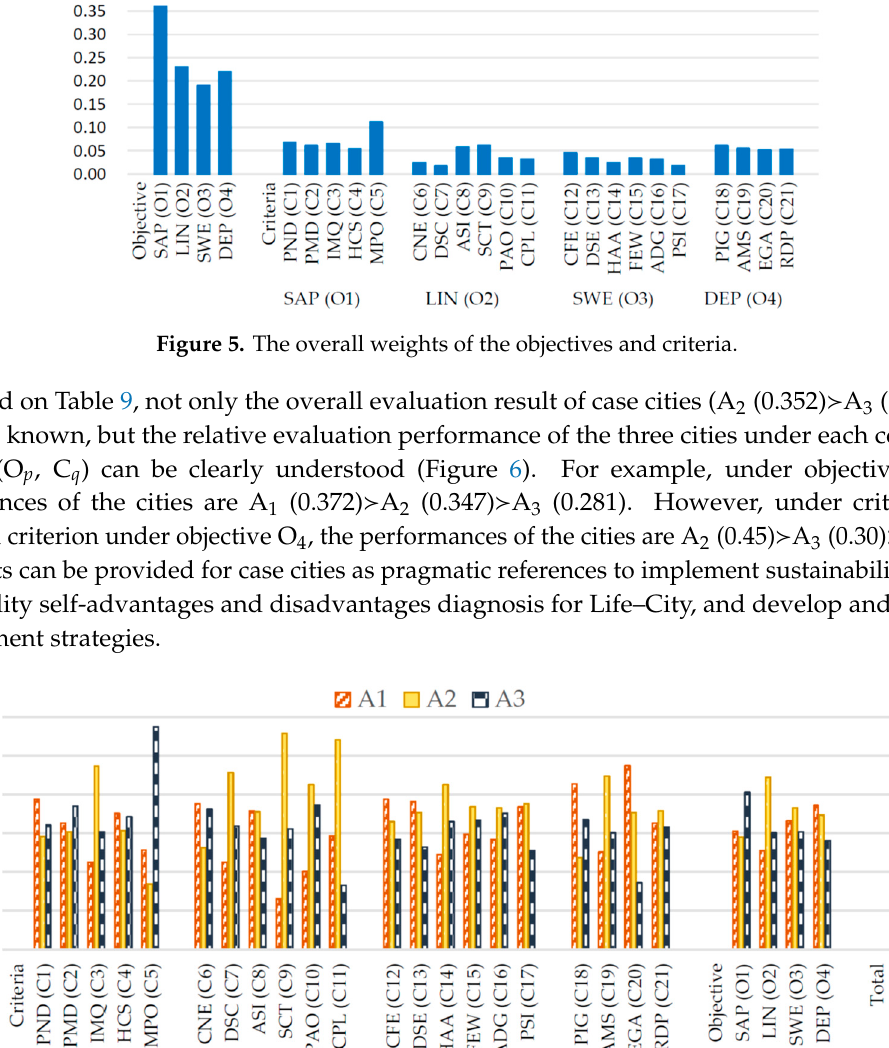
Figure 6. Performance of cities with respect to each objective and criterion.